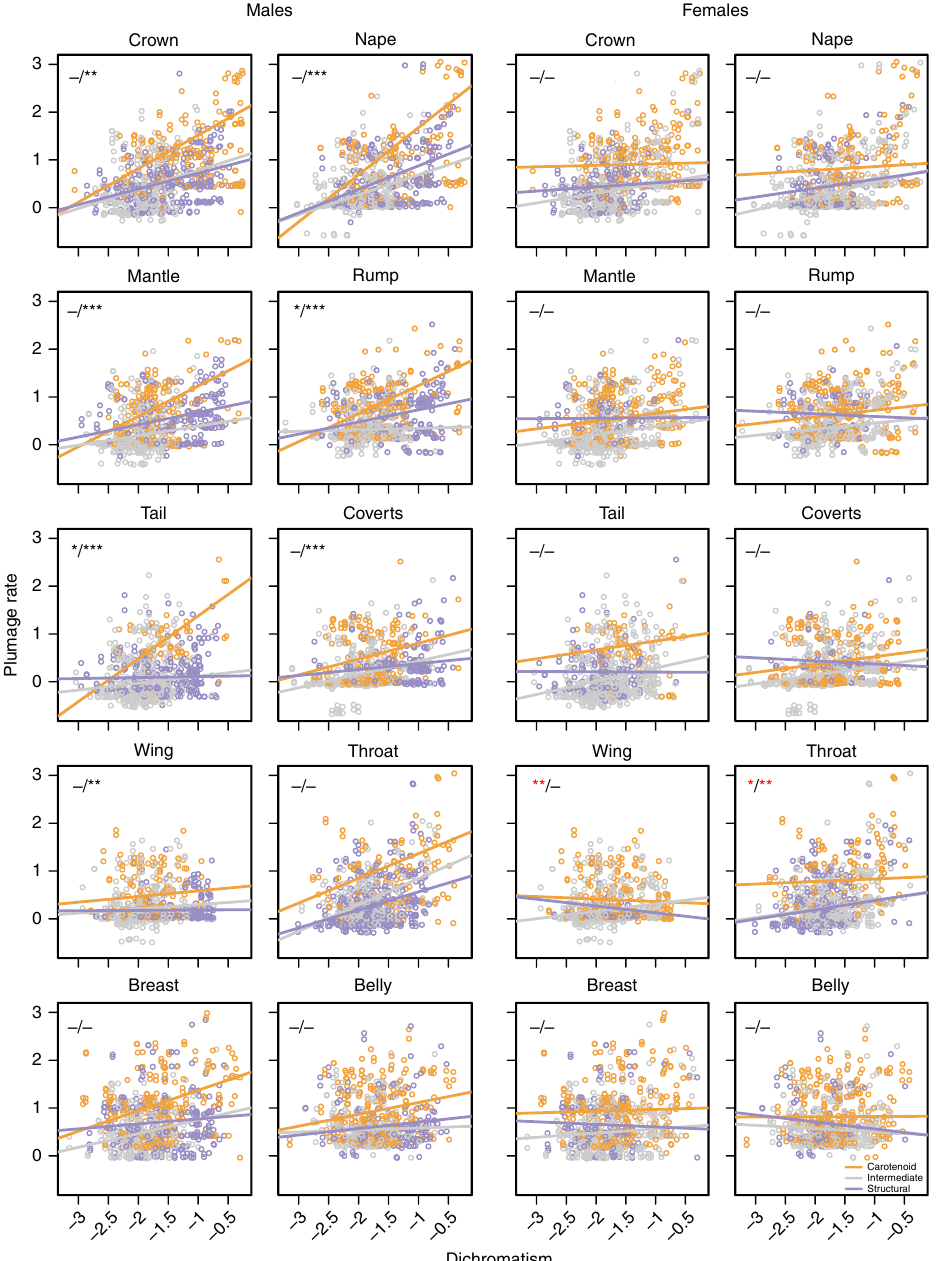
Fig. 3 Relationships between dichromatism and rate of plumage colour evolution within body regions for different colouration types. Regression lines are plotted separately for patches consistent with carotenoid-based (orange) or structural (lilac) colouration, as well as colouration intermediate between these two extremes (grey) (see Supplementary Methods). Asterisks indicate whether the slope of the carotenoid regression line (the reference category) is signi fi cantly more positive (black) or more negative (red) compared with the slope of the (i) intermediate and (ii) structural regression lines, respectively (i.e., carotenoid slope vs. intermediate slope, carotenoid slope vs. structural slope), based on Bayesian phylogenetic mixed-models. *** pMCMC < 0.001; ** pMCMC < 0.01; * pMCMC < 0.05; – non-signi fi